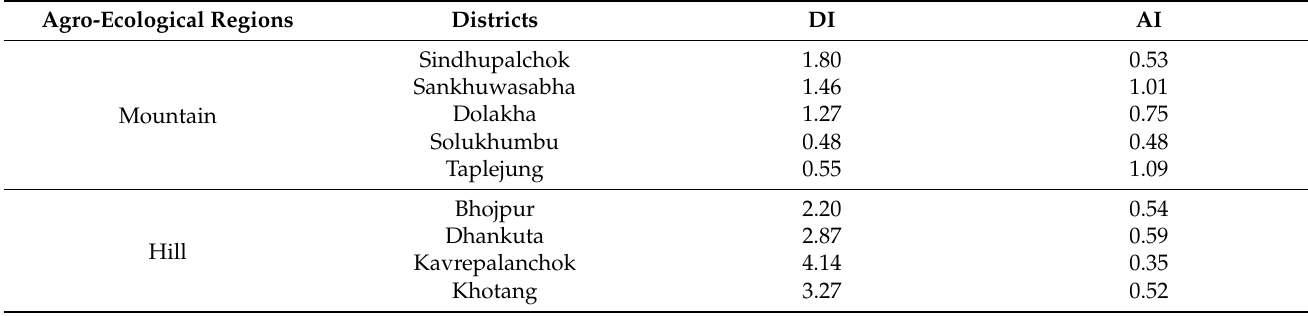
Figure 5. The DSI, DDI, ASI, and ADI in 27 districts and three agro-ecological regions. Table 2. The DI and AI in 27 districts.